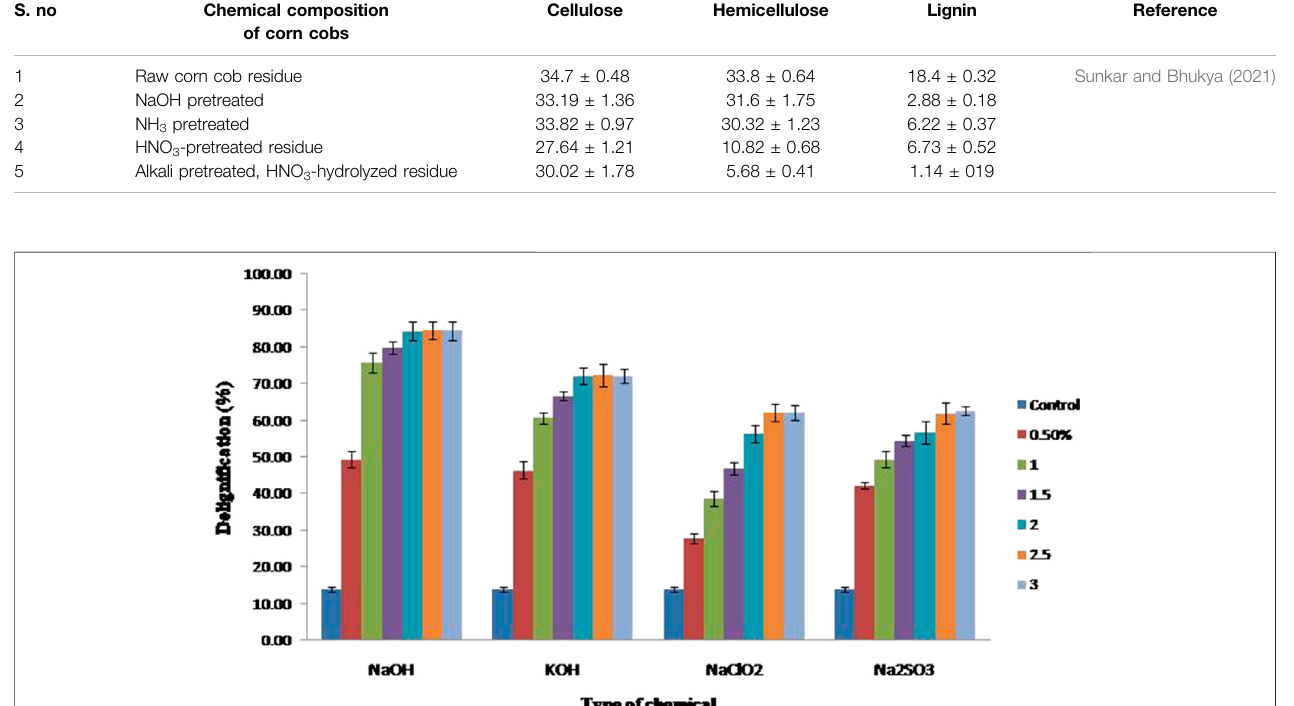
FIGURE 1 | Effect of different alkali-based chemicals on deligni fi cation of corn cobs with respect to different concentrations.